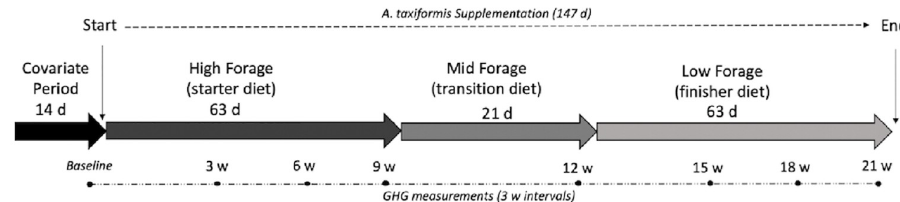
Fig 1. Experimental timeline including covariate period, Asparagopsis taxiformis implementation, dietary regime, and greenhouse gas measurement intervals.